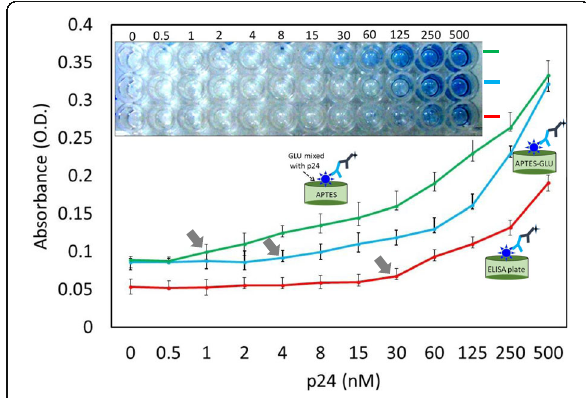
Fig. 5 Limit of detection for the HIV-p24 antigen. The p24 was titrated from 0.5 to 500nM. Three different approaches were followed, conventional and methods 1 and